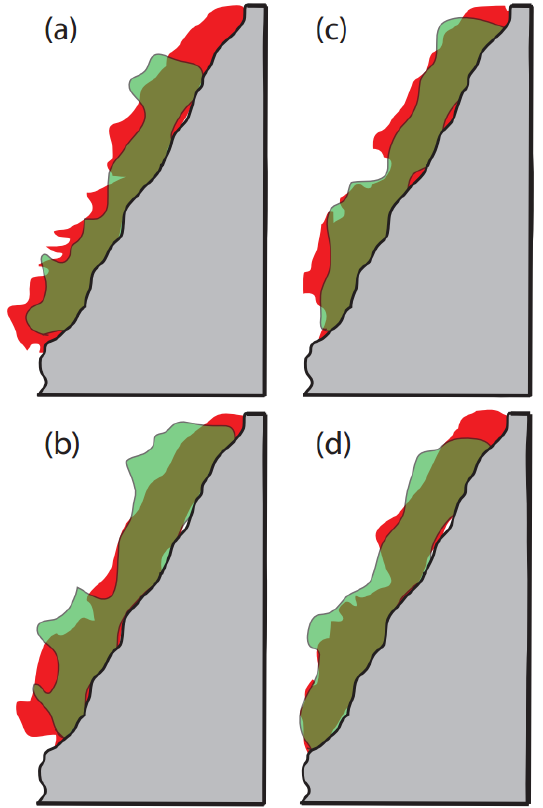
Figure 13. Comparison of STRiPE and POM simulation results. The green and red colours display the contours of the river plumes obtained by STRiPE and POM respectively at (a) 08:00, (b) 11:00, (c) 14:00, and (d) 17:00 GMT on 27 June 2013. The phases (b) and (d) correspond to the peak flood (northeastward) and ebb (south- westward) flows, respectively. The 32.5psu salinity contour delin- eates the river